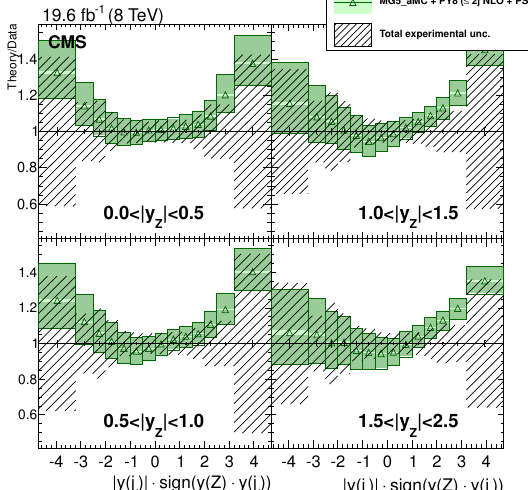
Figure 36 . Ratio to the measurement of the di(cid:11)erential cross section d 2 (cid:27)= d y (Z)d y (j with mg5 a mc + pythia 8, with up to two jets at NLO. The total experimental uncertainty is shown as a band around 1. Uncertainties in the predictions are shown on the ratio points and include the statistical, theoretical, and PDF uncertainties. The dark green area represents the statistical and theoretical uncertainties only, while the light green area represents the statistical uncertainty